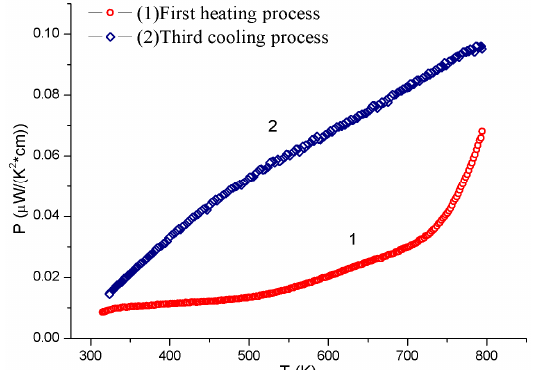
Figure 7. Temperature dependences of the power factor P for the first heating ( δ = 0.13 at T = 300 K) (1) and the third cooling ( δ = 0.21) (2).